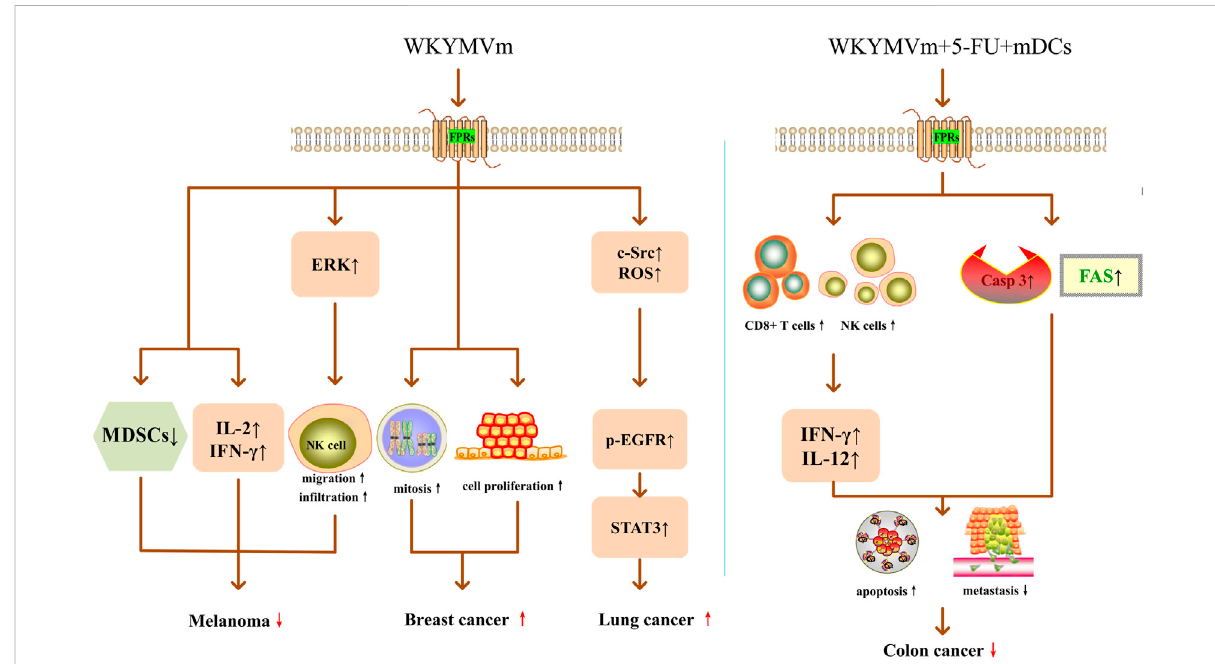
FIGURE 2 WKYMVm and cancer. Acting on FPRs, WKYMVm reduces the number of MDSCs, upregulates IL-2 and IFN- γ , and promotes NK cell migration and in fi ltration by activating ERK, thereby inhibiting the growth of melanoma cells. WKYMVm promotes mitosis and proliferation of breast cancer epithelial cells. WKYMVm increases c-Src expression, ROS production, and EGFR phosphorylation, triggers the STAT3 pathway, and promotes lung cancer cellproliferation.Combining with5-FU andmature DCs, WKYMVm recruits CD8 + Tlymphocytes and NKcells intotumorsto inducethe production of IFN- γ and IL-12, increases the expression levels of FAS and caspase-3, thereby inducing apoptosis and inhibiting metastasis of colon cancer cells. ERK, extracellular signal-regulated kinase; IL-2, interleukin-2; IFN- γ , interferon gamma; MDSCs, myeloid-derived suppressor cells; NK, natural killer; casp3, caspase-3; IL-12, interleukin-12; ROS, radical oxygen species; p, phosphorylation; EGFR, epidermal growth factor receptor; STAT3, signal transducer and activator of transcription3;5-FU,5- fl uoro-uracil; FAS, Fas cell surfacedeath receptor;mDCs, mature dendritic cells. ↑ , increase; ↓ , decrease; , promote; ,